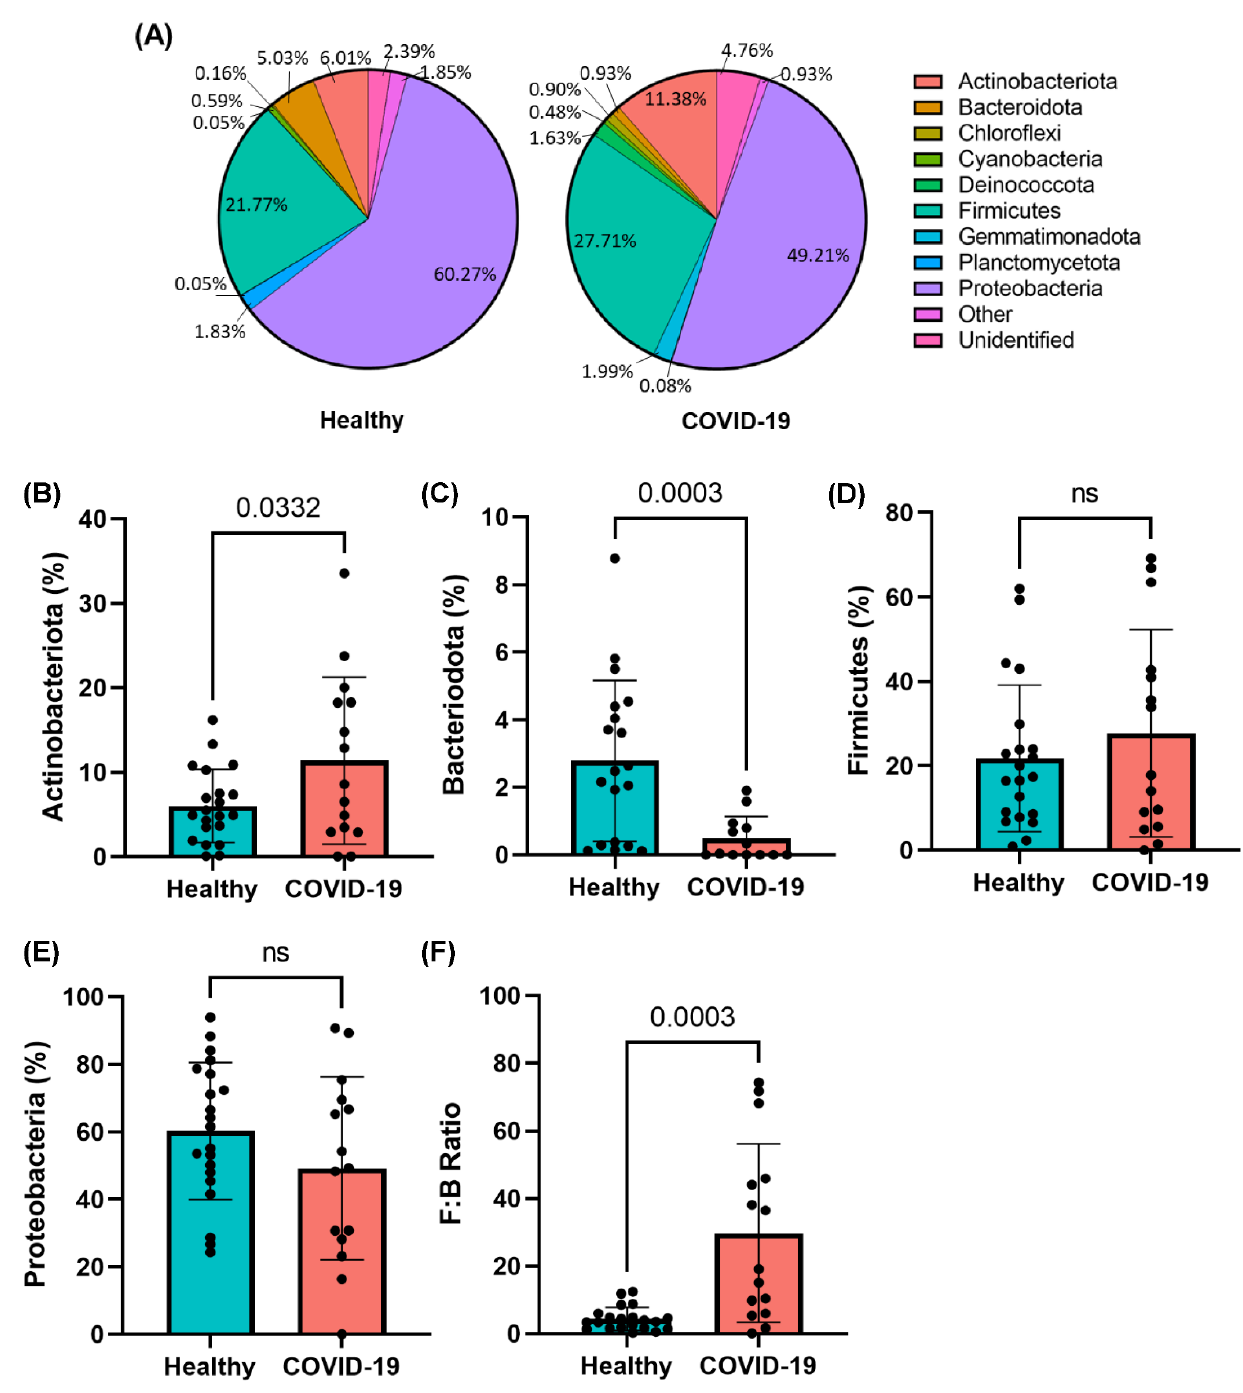
Figure 2. COVID-19-positive subjects exhibit significant dysbiosis of the plasma microbiome at the phylum level. ( A ) Pie charts representing dominant phyla that constitute the circulating microbiome in COVID-19-positive subjects. Individual phyla ( B – E ) which were found to be differentially abun- dant in the plasma of COVID-19-positive subjects including increased Actinobacteria and decreased Bacteroidota . ( F ) The Firmicutes:Bacteroidetes (F:B) ratio indicates a significant increase in dysbiosis of the dominant phyla. Data are presented as mean ± S.E.M. Each dot represents a sample in the cohorts. Student’s t-test p -values are indicated where applicable (ns, p >